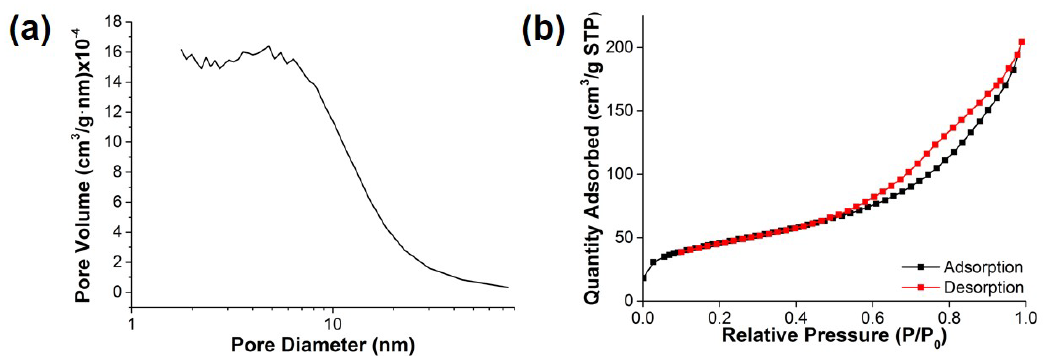
Figure 4. Representative ( a ) pore size distribution and ( b ) N 2 adsorption/desorption isotherm of the